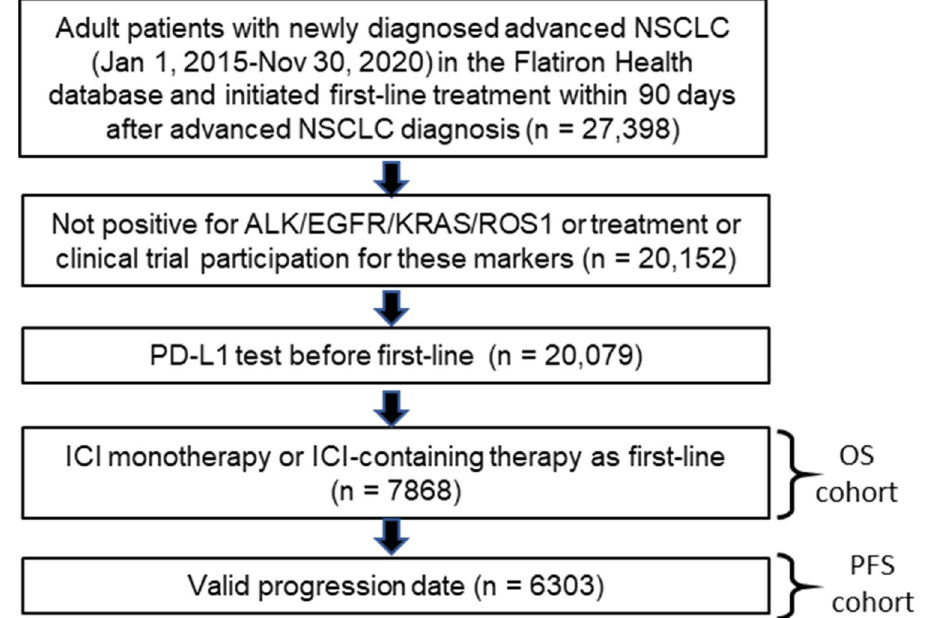
Figure 1. Population attrition after applying inclusion and exclusion criteria. ALK , anaplastic lymphoma kinase; BRAF , B-Raf proto-oncogene; EHR, electronic health record; ICI, immune checkpoint inhibitor; KRAS , Kirsten rat sarcoma virus; NSCLC, non-small cell lung cancer; OS, overall survival; PFS, progression-free survival; ROS1 , C-ROS oncogene